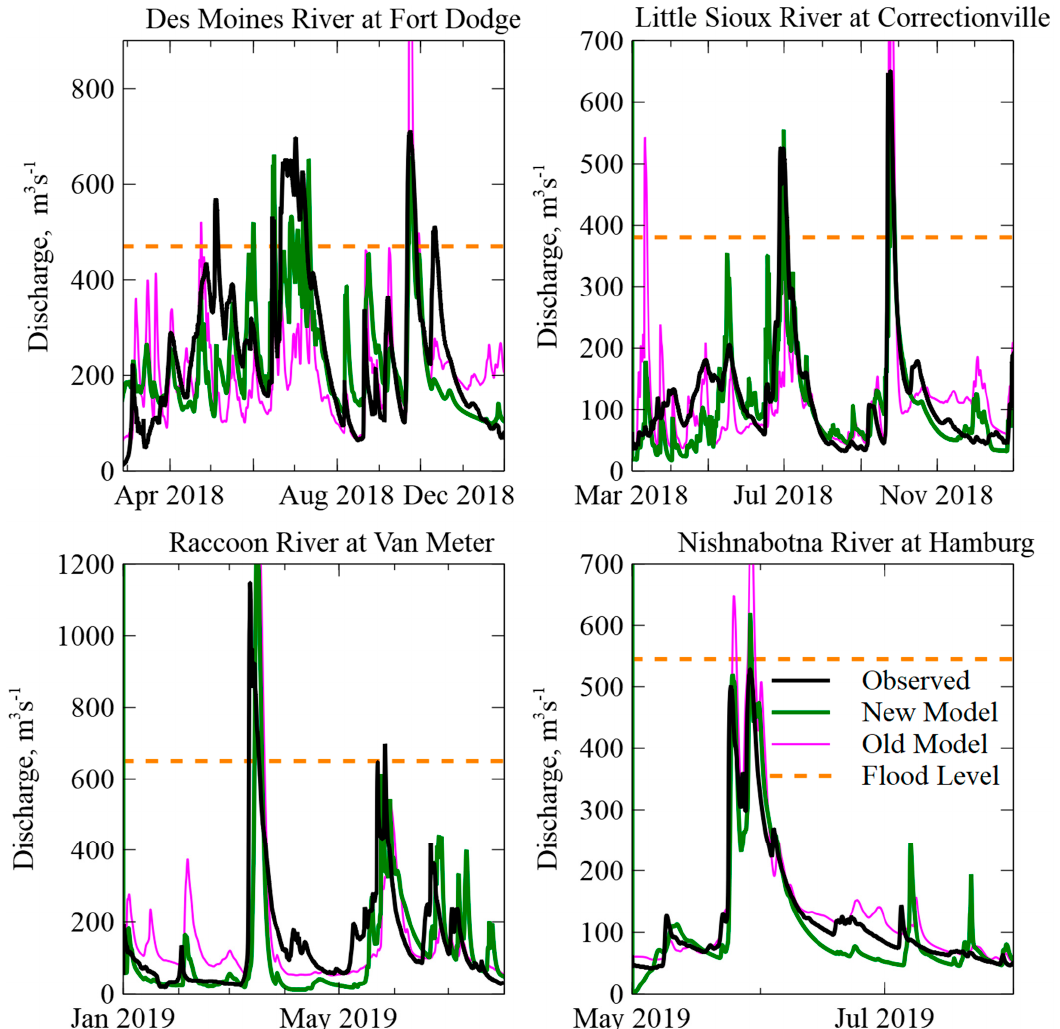
Figure 5. Flow simulations obtained at basins of the Des Moines Lobe landform (left column) and basins in Western Iowa.